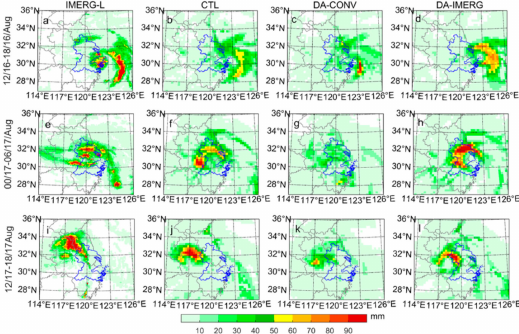
Figure 9. Spatial distribution of 6 h accumulated precipitation (mm) for: ( a , e , i ) IMERG, ( b , f , j ) CTL, ( c , g , k ) DA-CONV, and ( d , h , l )